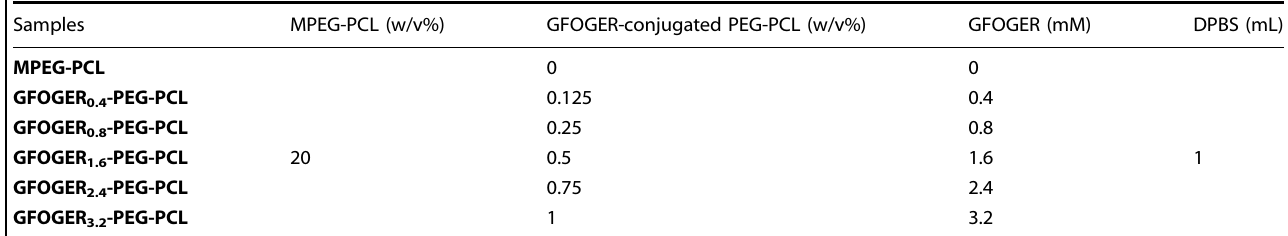
Fig. 9 Micro-CT scanning. a Reconstructed micro-CT images in sagittal planes of the representative excised knee specimen from each experimental group at 4 and 8 weeks after implantation (White arrows indicate the defect site). And the white frames indicate the magni fi ed defect area. 3D view of extracted bone from region of interest (ROI). b Quantitative analysis of reconstructed micro-CT images was used to analyze the ratio of bone volume to tissue volume (BV/TV) (Data in ( b ) are shown as mean ± SD, unpaired Student ’ s t -test. * p < 0.05 and ** p < 0.01). Table 1. Details of the quantity MPEG-PCL and GFOGER-PEG-PCL used for preparing the hydrogel blend